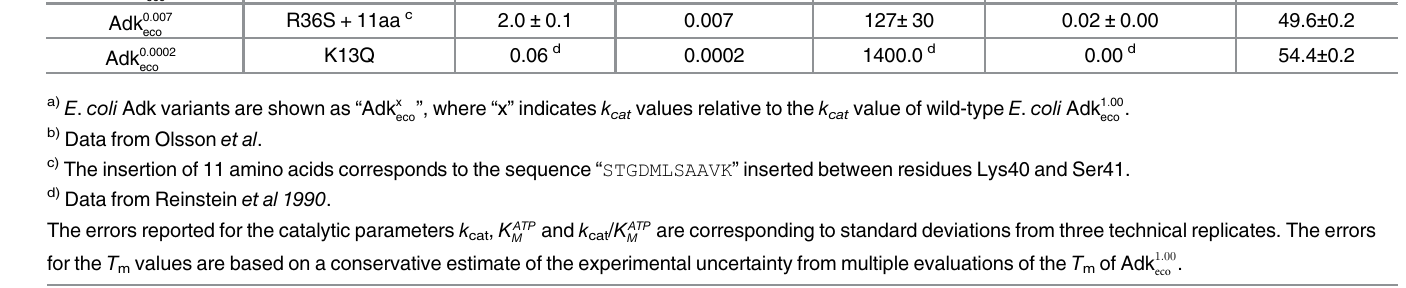
with an XbaI restriction site. To obtain pRS315- adk eco , a DNA fragment encoding the wild- type E . coli adk open reading frame was PCR-amplified and exchanged with the XbaI site in